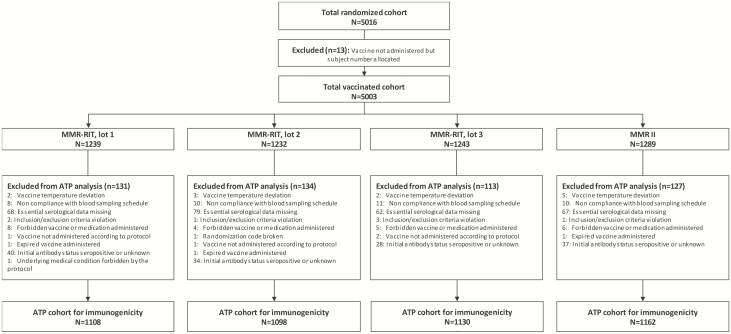
Flow diagram of the study participants. Abbreviations: ATP, according-to-protocol; N, number of children; n, number of children within the category.